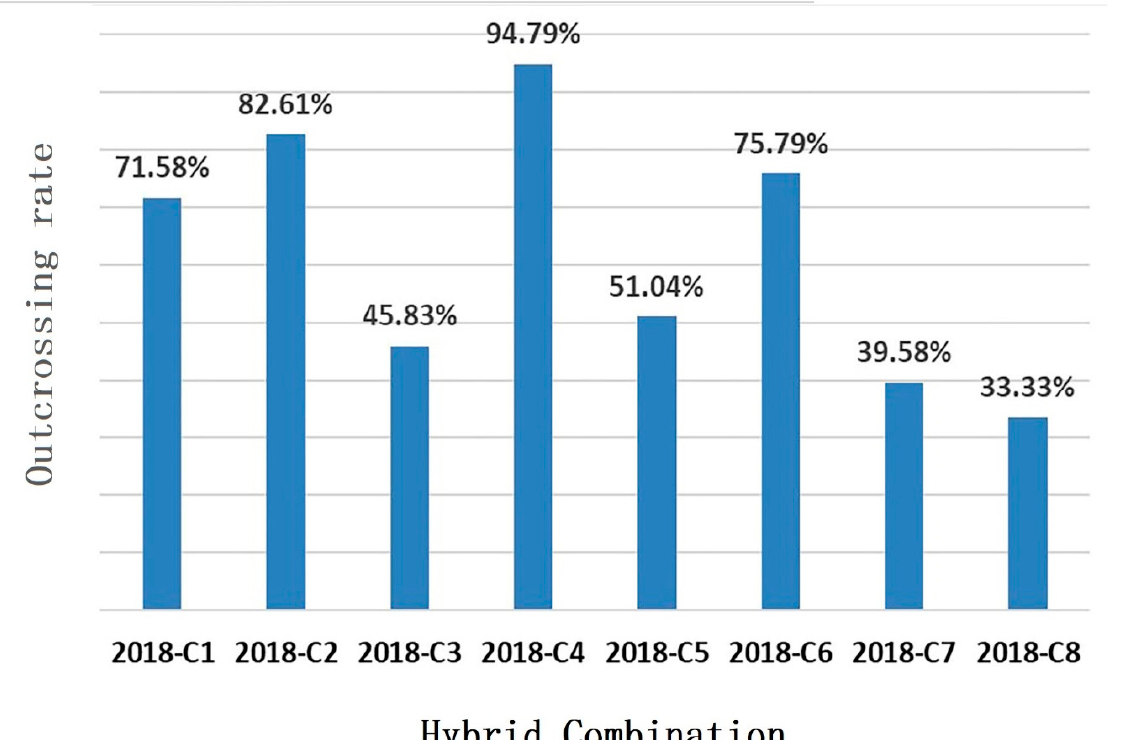
Figure 6. Outcrossing rate for aborted and deformed seeds of each combination in 2018.